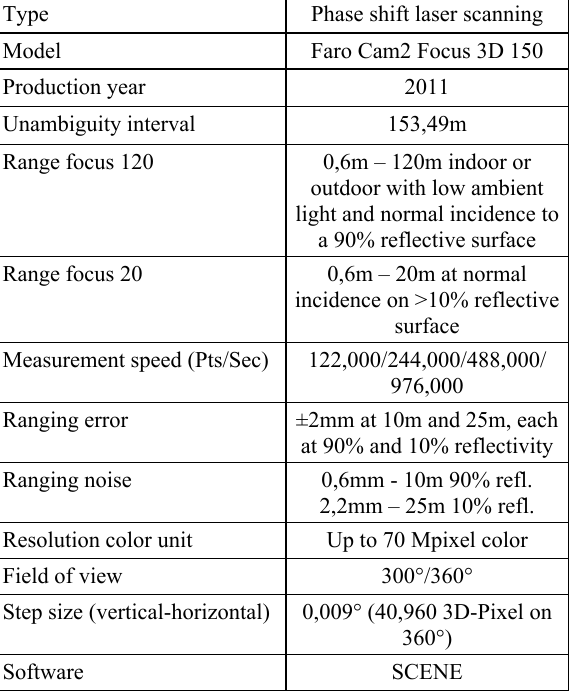
Table 1. Performance specifications of “ Faro Cam2 Focus 3D 150.